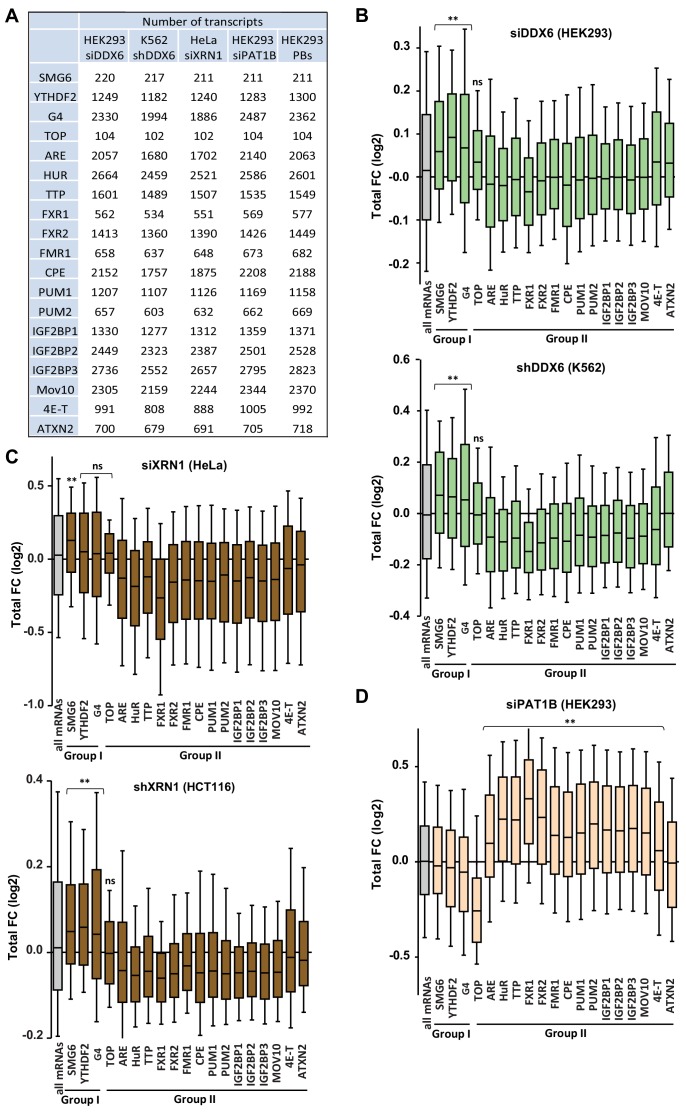
Targets of group I and II regulators (part I).(A) Number of transcripts in the mRNA subsets analyzed in (B–D) and in Figure 5A,B, Figure 5—figure supplement 2A–D and Figure 5—figure supplement 4. (B) Sensitivity of the different mRNA subsets to DDX6 silencing in HEK293 (upper panel) and K562 cells (lower panel). The behavior of all mRNAs is shown for comparison (in gray). Only the targets of group I factorsaccumulated following DDX6 depletion. While the presented analysis uses the YTHDF2 targets reported in Vindry et al. (2019), the same pattern was observed using the targets reported in Ozgur et al. (2010). (C) Sensitivity of the different mRNA subsets to XRN1 silencing in HeLa (upper panel) and HCT116 cells (lower panel). Only the targets of group I factors accumulated following XRN1 depletion in HCT116 cells, and only SMG6 targets did so in HeLa cells. (D) Sensitivity of the different mRNA subsets to PAT1B silencing in HEK293 cells. Only the targets of group II factors accumulated following PAT1B depletion, except ATXN2. Two-tail Mann-Whitney test was performed with respect to all mRNAs. **, p<0.0001; ns, non-significant.